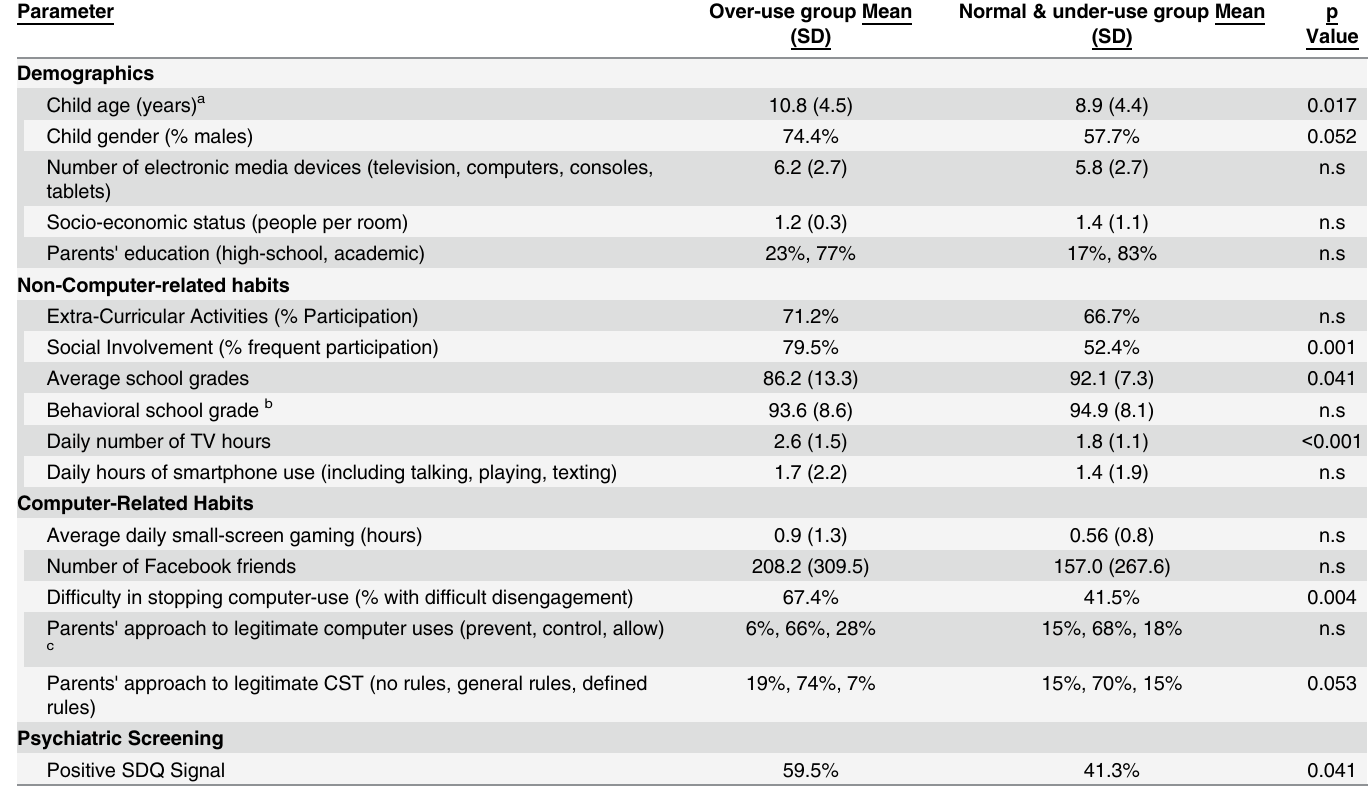
Table 2. Characteristics of the over-use versus normal & under-use groups, univariate analysis. Group comparisons were performed using T-test for continuous measures, and χ 2 for categorical measures. Parameter Over-use group Mean